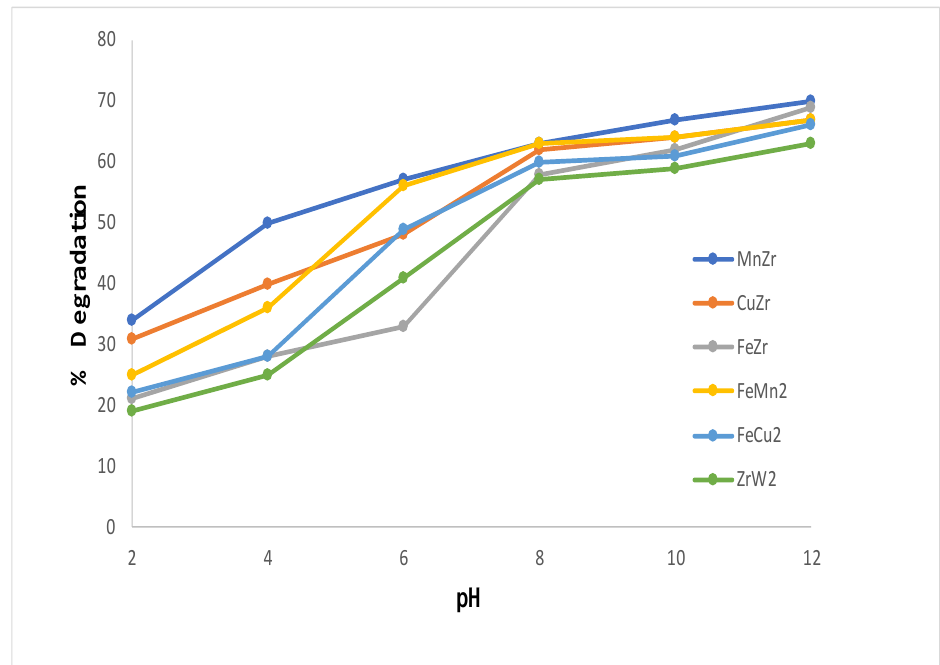
Figure 8. pH impact on photocatalytic degradation of phenolic compounds using doped and undoped systems for 1 day contact time; pHs ranging from 2 to 12.